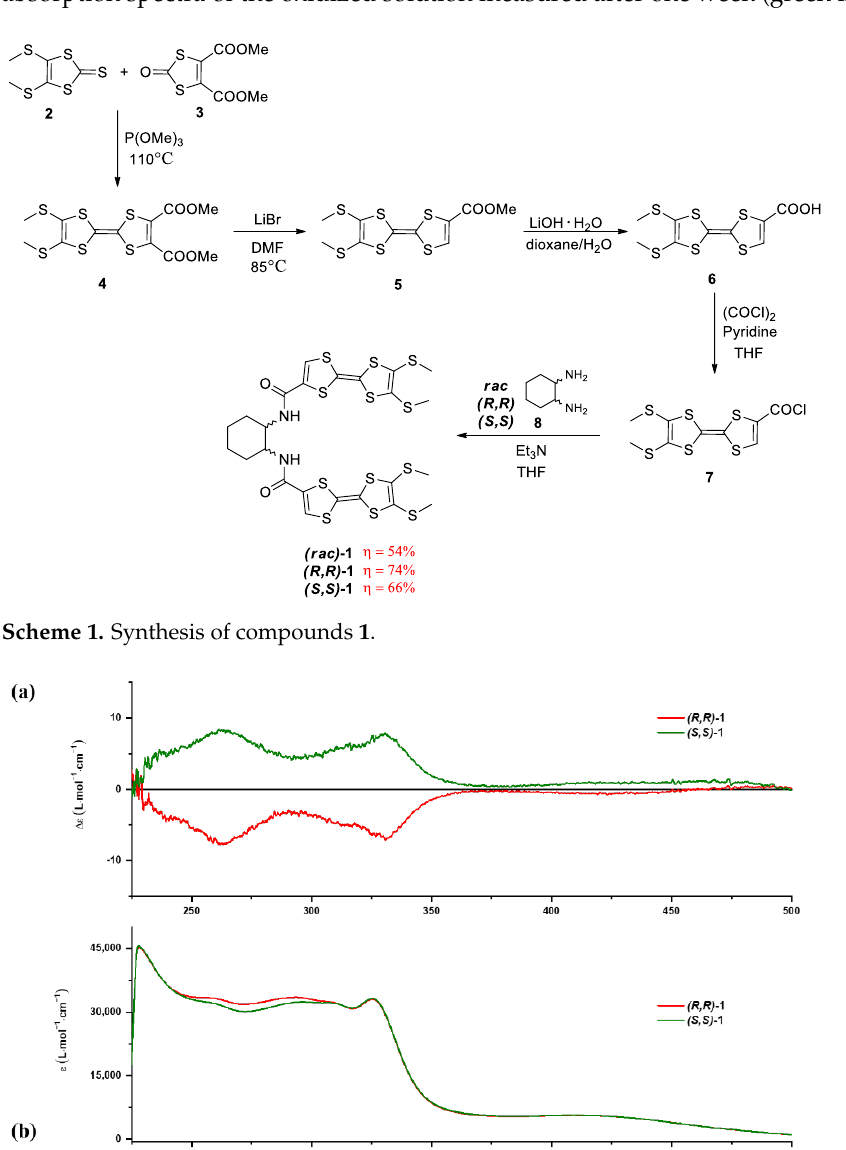
Figure 2. CD ( a ) and UV-Vis ( b ) spectra of compound 1 pair of enantiomers. Green line: ( S , S ) enan- tiomer, red line: ( R , R ) enantiomer.